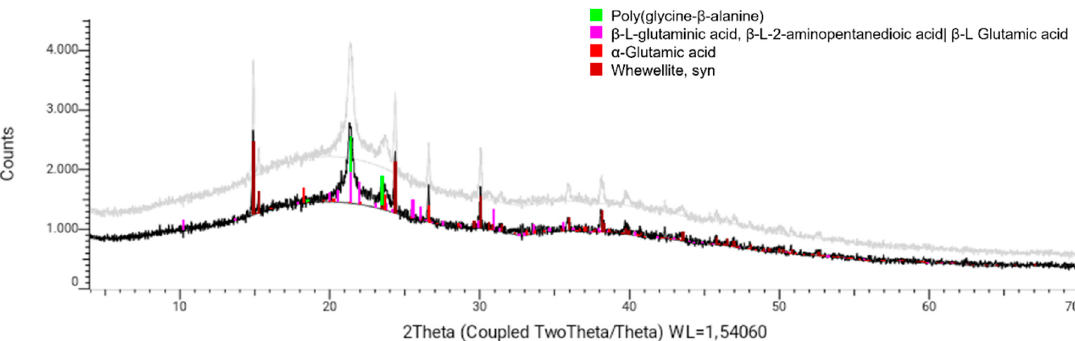
Figure 5. X-ray powder diffraction pattern (black line) from a solid sample of OFI fruit peel mucilage. The gray line is an overlay of the same diffraction pattern for better viewing.